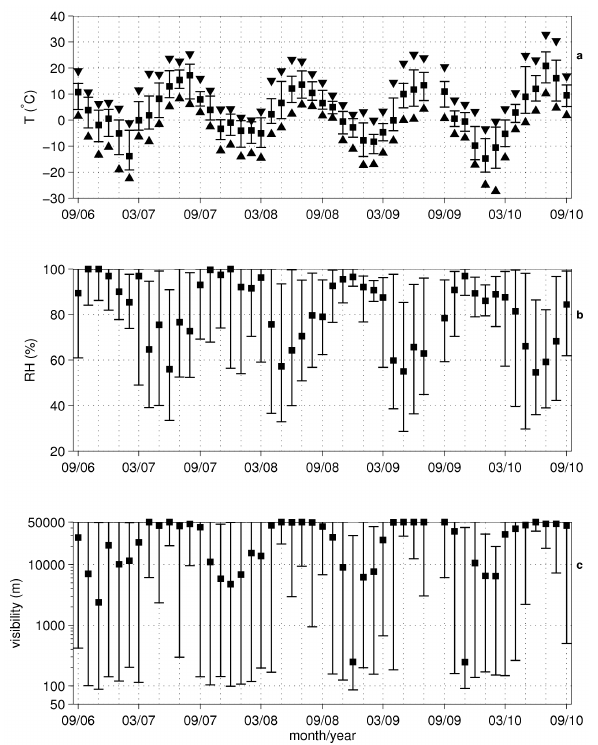
Fig. 3. 733 Fig. 3. Monthly 10th percentile (lower error bar), median (square), and 90th percentile of (a) total scattering coefficient at 550nm, (b) back scattering coefficient at 550nm, and (c) absorption coefficient at 637nm at Puijo in September 2006–September